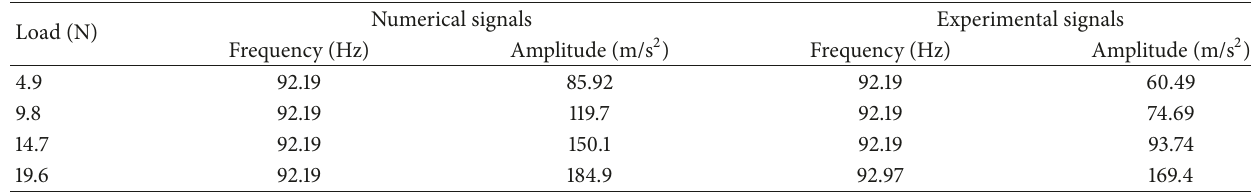
Table 2: Comparison of the fault signals in Figure